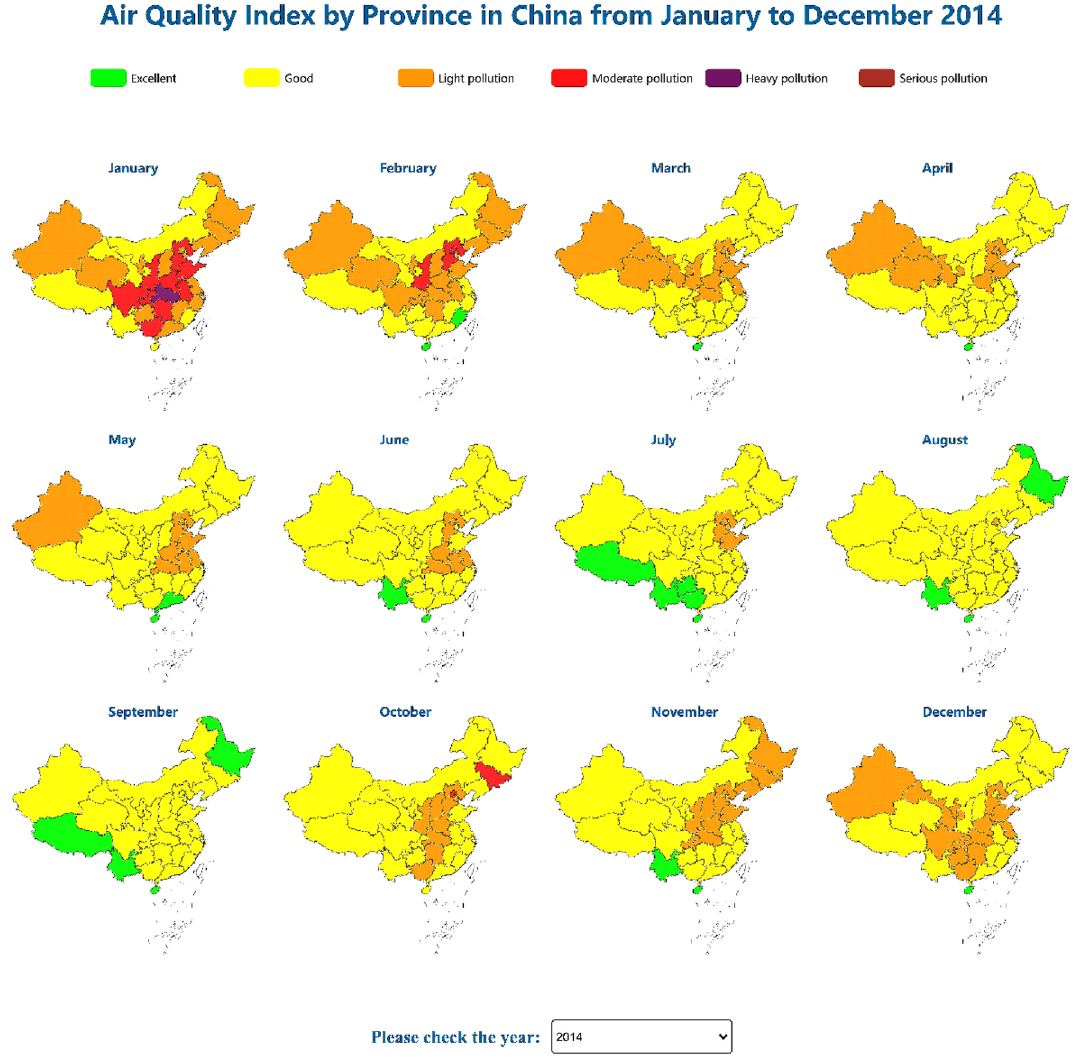
Figure 1. Spatiotemporal maps of the air quality